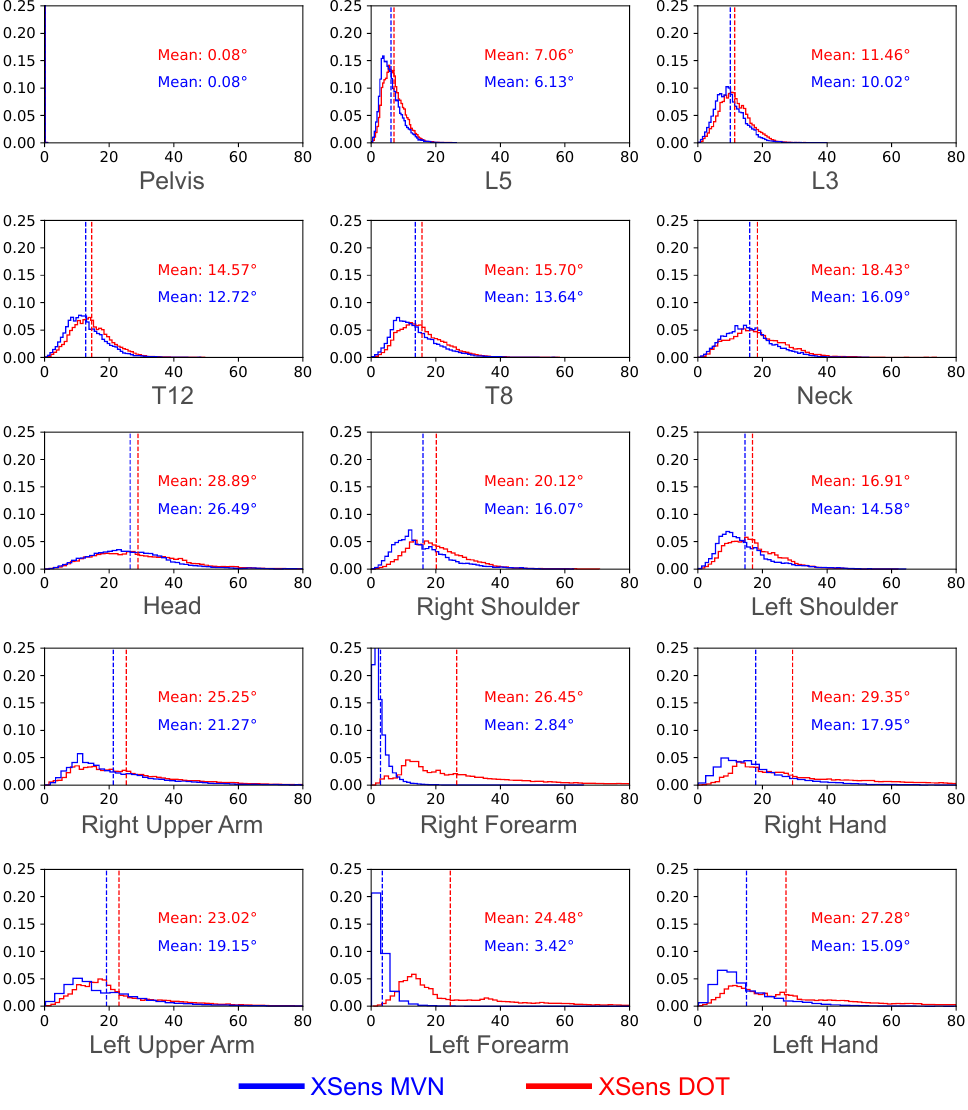
Figure 20. Segment orientation errors for each segment in the XSens model. X -axis is angle in degrees. Blue histograms show the angular error distribution for the MVN segments, while red histograms show the angular error distribution using the DOT sensors. The mean error is shown in each case. Next, we computed histograms of the error between the ground truth joint angle and the joint angles predicted by either the MVN sparse segments or the DOT sensors (Figure 22). To find these values, we took the ground truth joint angles (as computed above) and subtracted from them the inferred joint angles (from the MVN and DOT sensors separately). In these graphs, negative values indicate that the inferred angle predicted a more acute angle than the ground truth. For the shoulder, negative values indicated that the arm was closer to the side than the ground truth. In each case, the mean joint angle error was less than 4.0 ◦ for both the MVN sparse sensors and the DOT sensors. The error distributions were approximately symmetric around zero in both